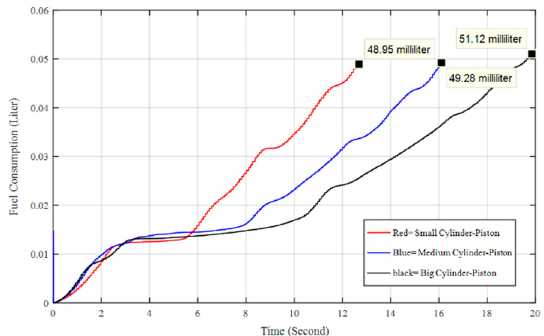
Figure 10. Comparison of fuel consumption for three arm-attached cylinders.